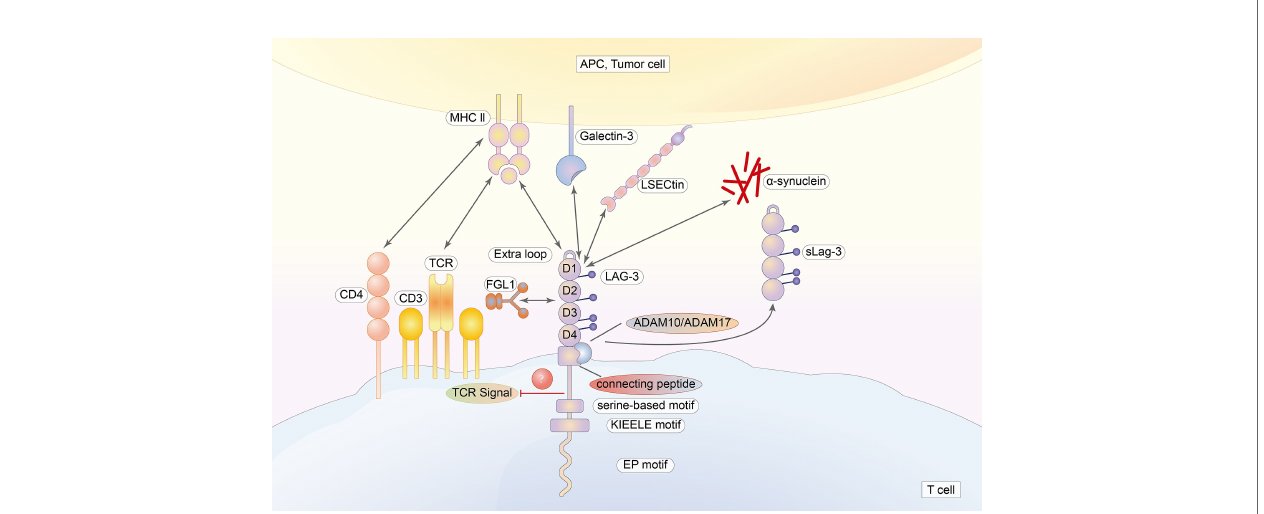
FIGURE 2 | The extracellular region of LAG-3 is composed of four immunoglobulin superfamily domains (D1 – D4). The cytoplasmic tail of LAG-3, incorporating three regions, is highly conversed. LAG-3 binds to MHC class II with higher af fi nity than that of CD4 via an “ extra loop ” in the D1 domain. Galectin-3, LSECtin, FGL, and a - synuclein are also ligands for